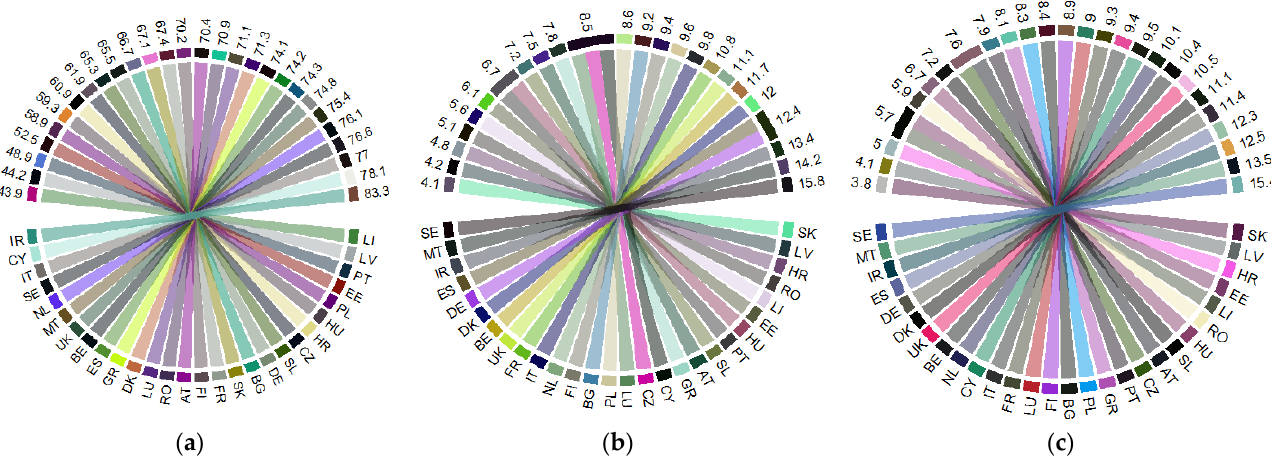
Figure 2. Health indicators in the EU in 2017: ( a ) “Share of people aged 16+ with good or very good perceived health” (%) (PGPH); ( b ) “Healthy life years in absolute value at 65—females (years)” (HLY_F); ( c ) “Healthy life years in absolute value at 65—males (years)” (HLY_M) . Source: own process in R version 3.6.3. (R Foundation, Free Software Foundation’s GNU